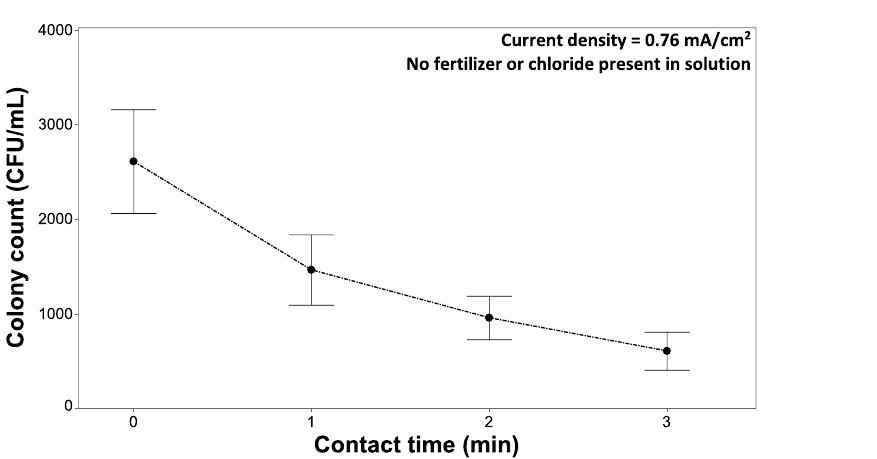
Figure 3. Inactivation of Rhizoctonia solani as a function of contact time, while maintaining a constant current density of 0.76 mA/cm 2 . The test solution only contained deionized water with free floating mycelia and did not contain fertilizer or chloride salts for the experiment. Without the presence of a supporting electrolyte in solution gave an operating voltage for this specific experiment ∼ 32 volts. Error bars are ± SEM, n = 3.